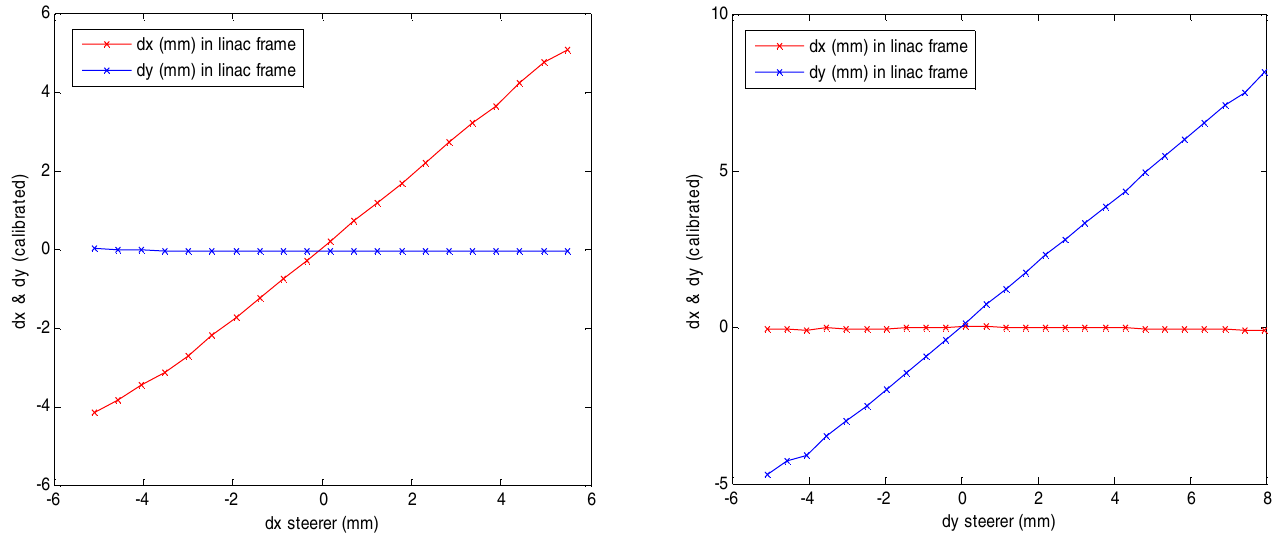
FIG. 17. (Color) Calibration results from horizontal (left) and vertical (right)